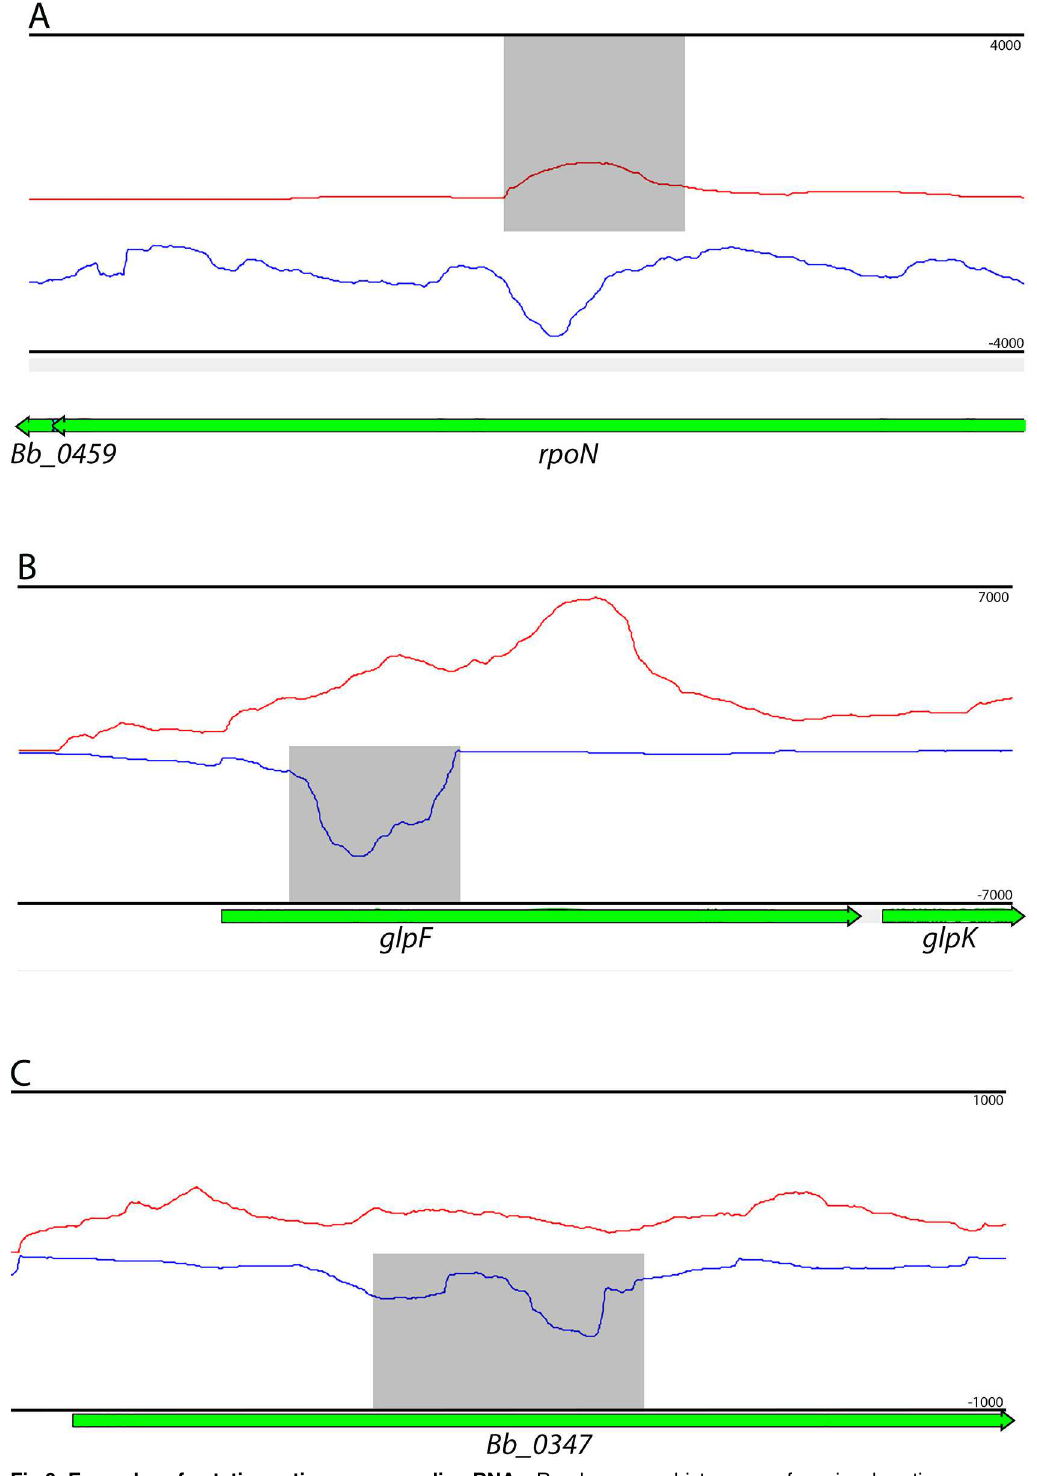
Fig 6. Examples of putative antisense noncoding RNAs. Read coverage histograms of previouslyantisense ncRNAs that overlap; rpoN , glpF , and ORF Bb_0347 .Read Red lines indicate transcript abundance from the + strand (left to right) and blue indicate transcript abundance from the–strand (right to left), and are shown above (+) and below (-) the central axis. Genes are noted below coverage plots and directionality is given by arrows at the ends of